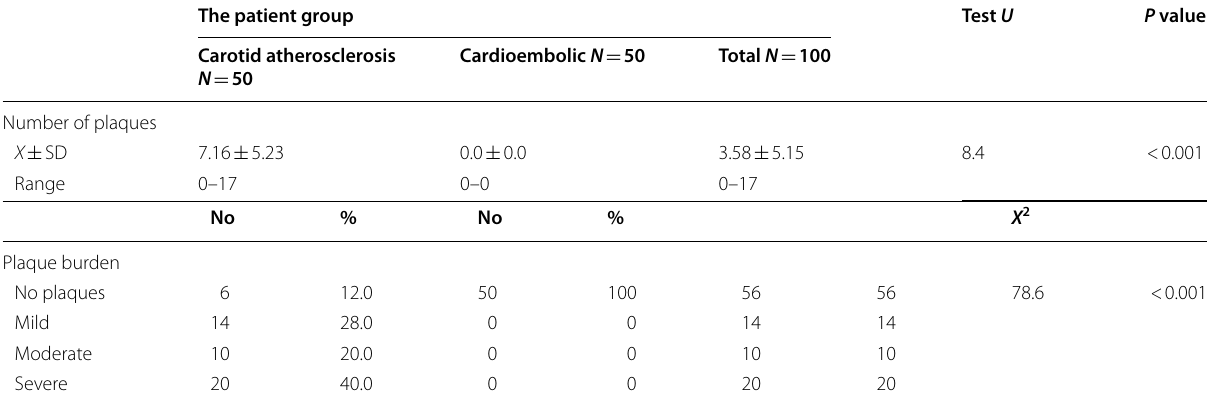
Table 4 Carotid plaque burden among atherosclerotic and cardioembolic groups